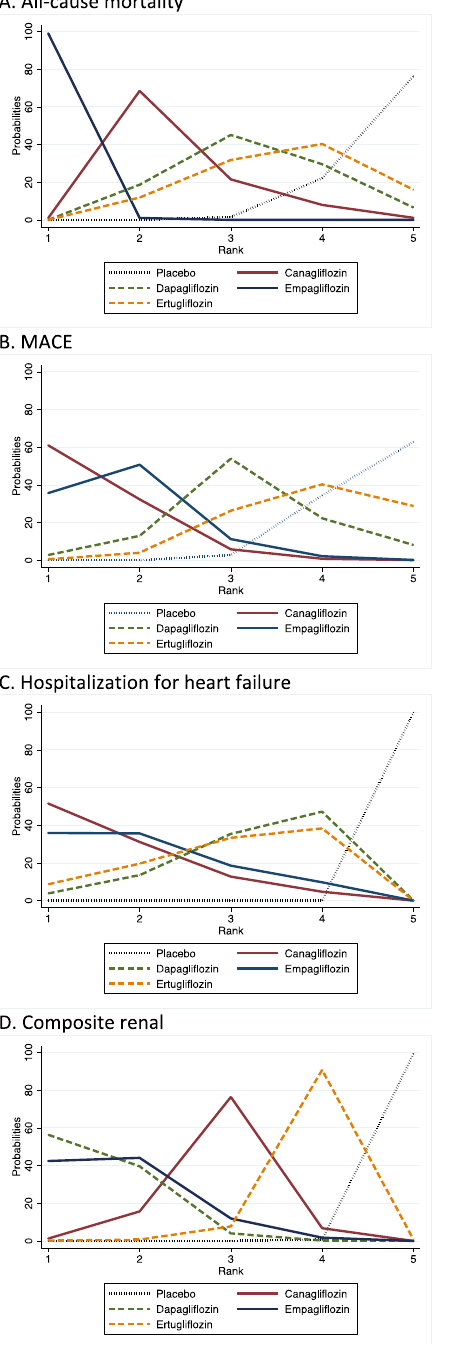
Figure 6. Relative rankings of treatments. ( A ) All-cause mortality; ( B ) MACE; ( C ) Hospitalization for heart failure and ( D ) Composite Renal.